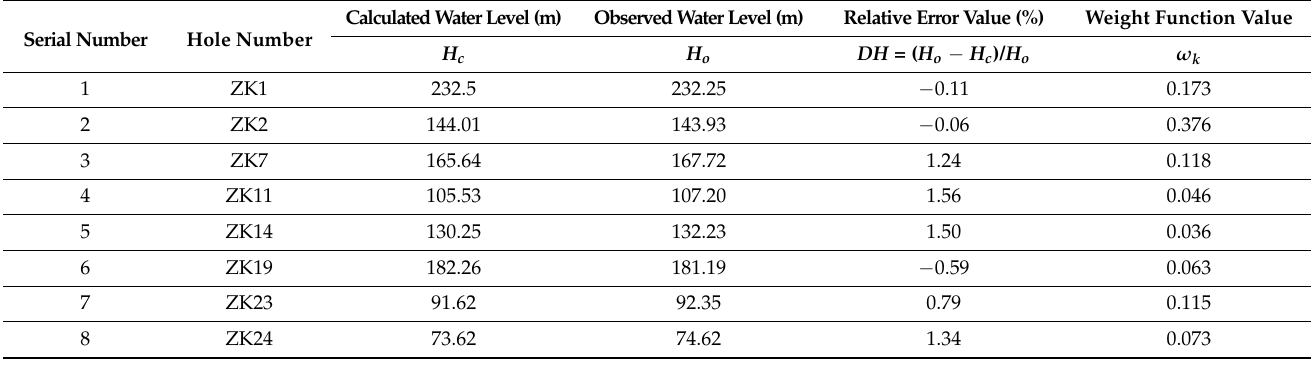
Table 2. Fitting parameters for the observed and calculated water levels in boreholes on 12 January 2004.